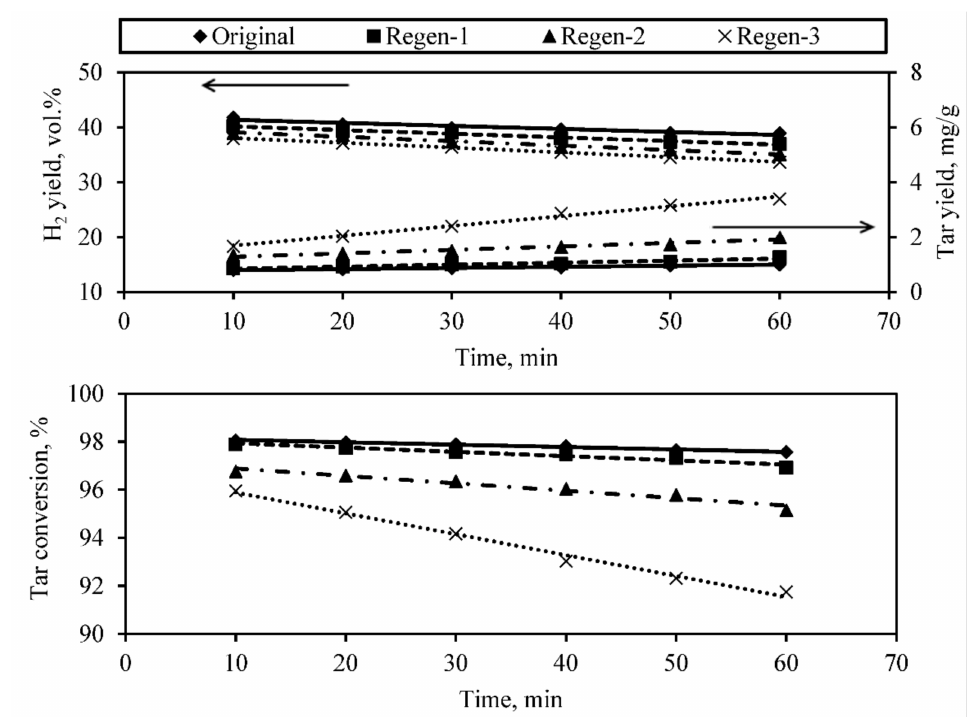
Figure 8. Secondary catalyst performance under multiple re-use/regeneration